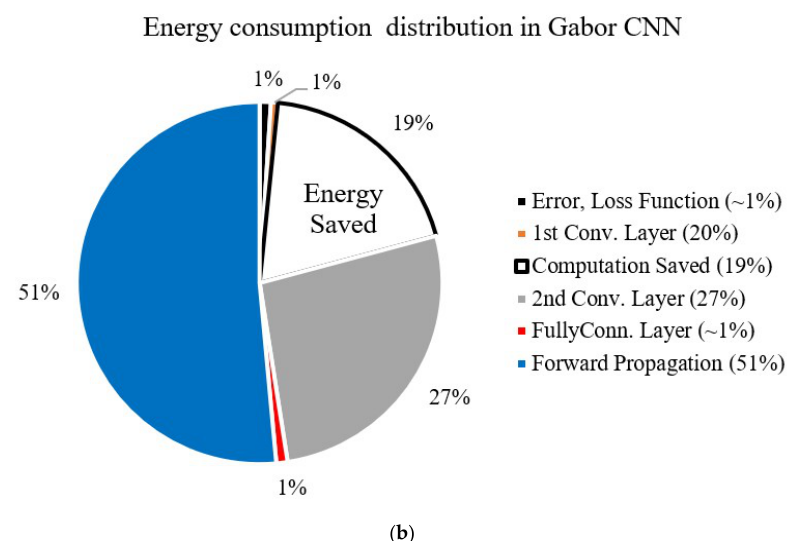
Figure 10. Energy consumption distribution: ( a ) conventional CNN and ( b ) Gabor CNN on MINIST.